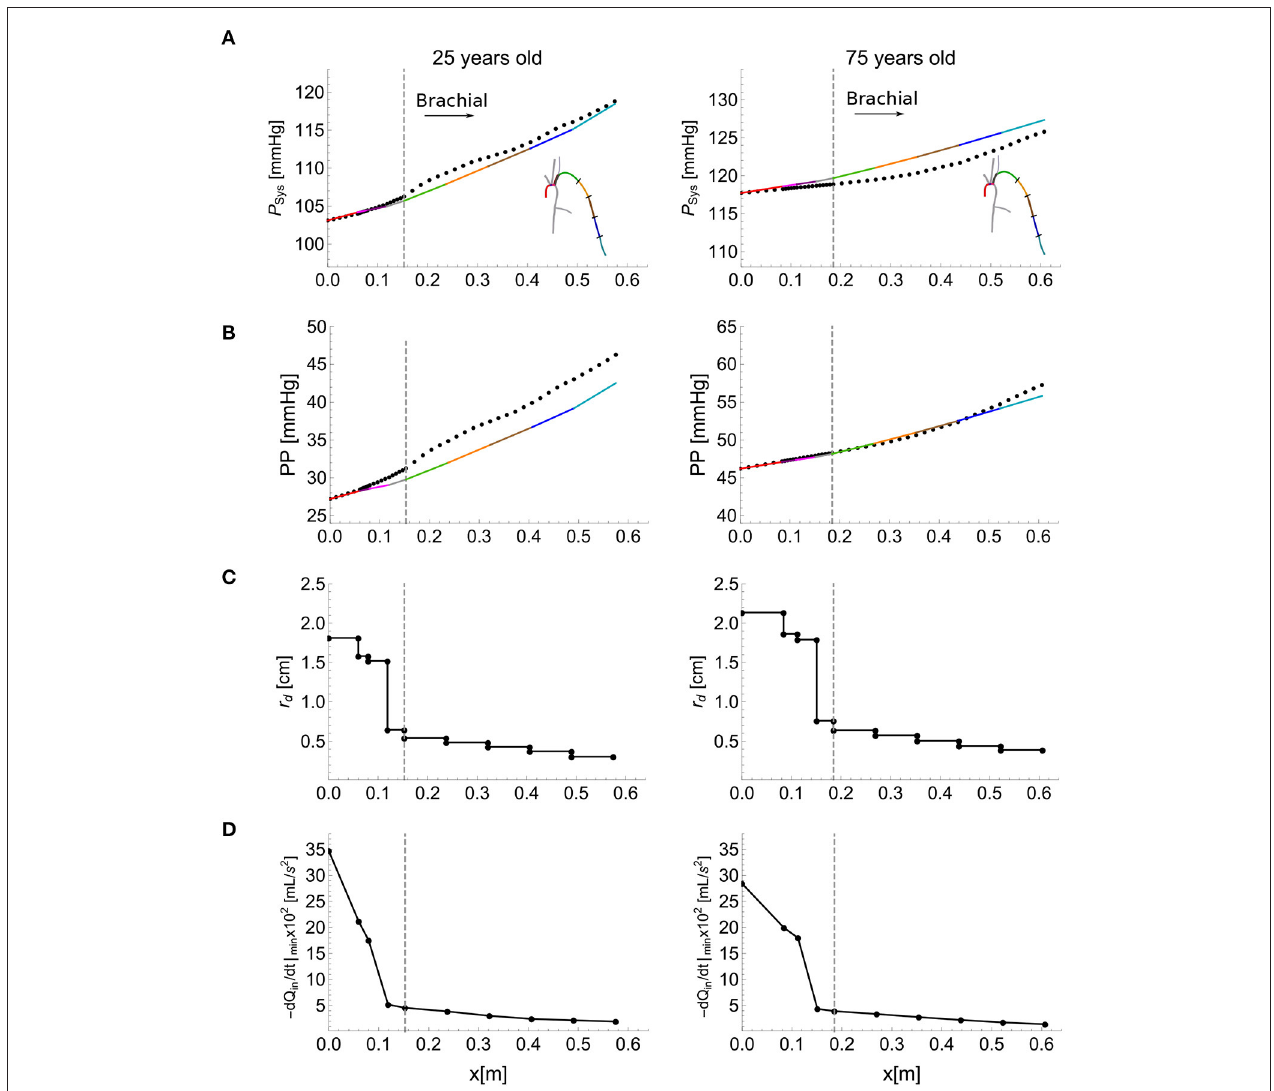
FIGURE 6 | Calculation of systolic blood pressure, P Sys , and pulse pressure, PP, using the single-vessel model. P Sys (A) , and PP (B) (solid lines) calculated using Equations (8) and (9), respectively. The dots show the corresponding values obtained by the reduced model. Luminal diastolic radius, r d (C) , and maximum temporal rate of decrease in late-systolic flow, − d Q in / d t | min from the reduced model (D) at the inlet and outlet of each segment of the aortic-brachial arterial path, for the baseline 25 (left) and 75 (right) year-old subject from the in silico dataset. Dashed vertical lines indicate the start of the brachial artery.